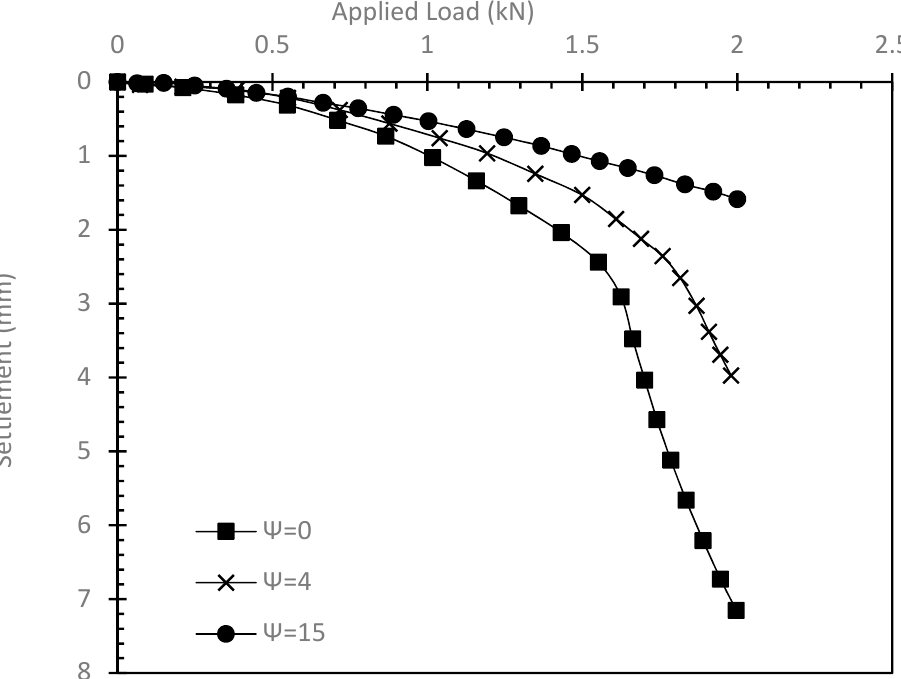
Figure 19. Effect of sand dilation under an axial load on CFRP pile settlement.